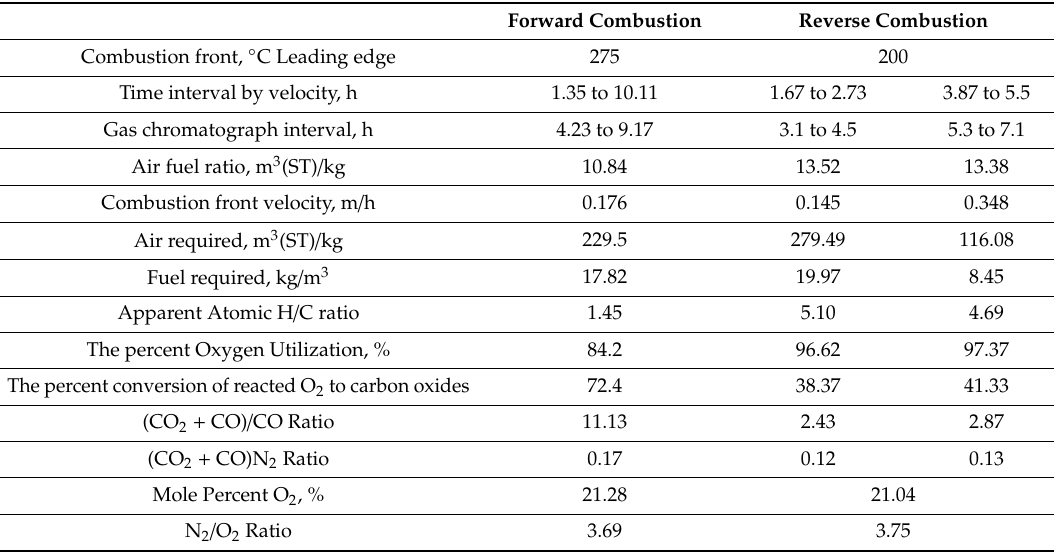
Table 2. Summary of stabilized combustion